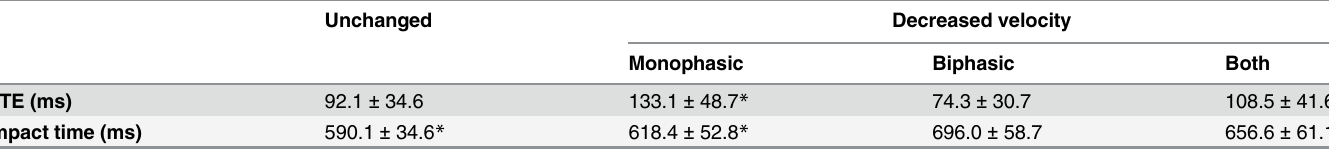
Table 1. Absolute temporal error (ATE) and impact time from when a target starts to move (impact time) in response to unchanged and decreased velocity